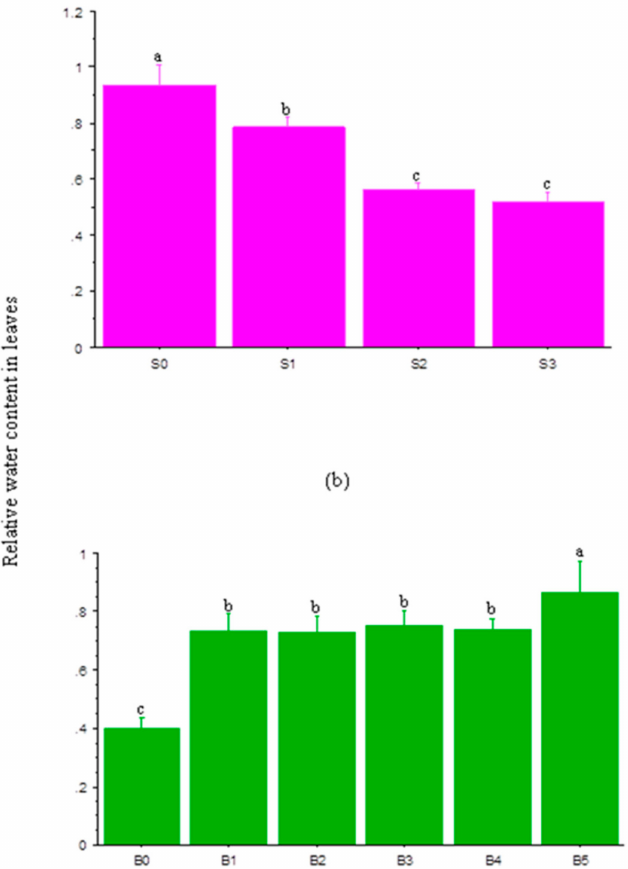
Figure 3. Single effects of salinity ( a ) and brassinolide ( b ) on relative water content in leaves at BL1—BL application at seedling; BL2—BL application at flowering; BL3—BL application at podding; BL4—BL application at seedling + flowering; B5—BL application at seedling + flowering + podding; S0—1.10 mM/L (control); S1—32.40 mM/L; S2—60.60 mM/L; S3—86.30 mM/L. Mean pairs